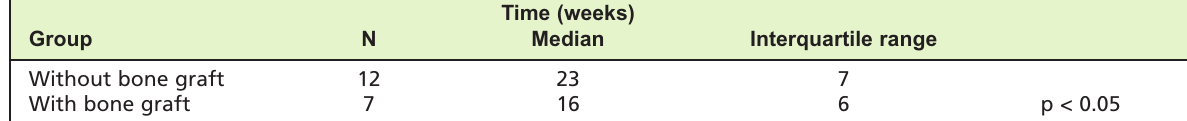
Data showing mean, standard deviation and p value Table I: